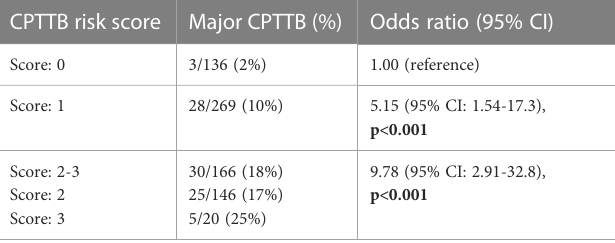
TABLE 4 The performance of the CPTTB risk score for predicting major CPTTB is tabulated below. CPTTB risk score Major CPTTB